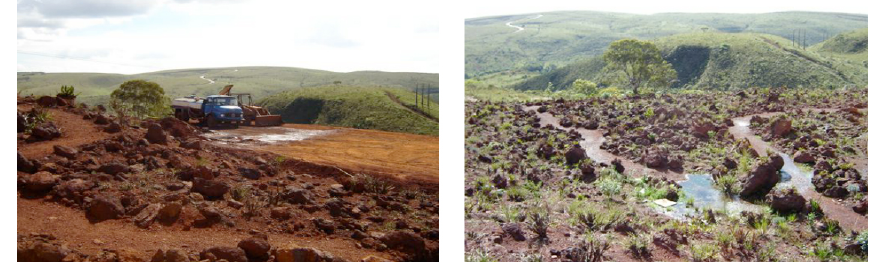
Figure 1. Surrounding area of the park headquarters before and after the canga vegetation translocation. Photo credit: A. F. Fernandes.